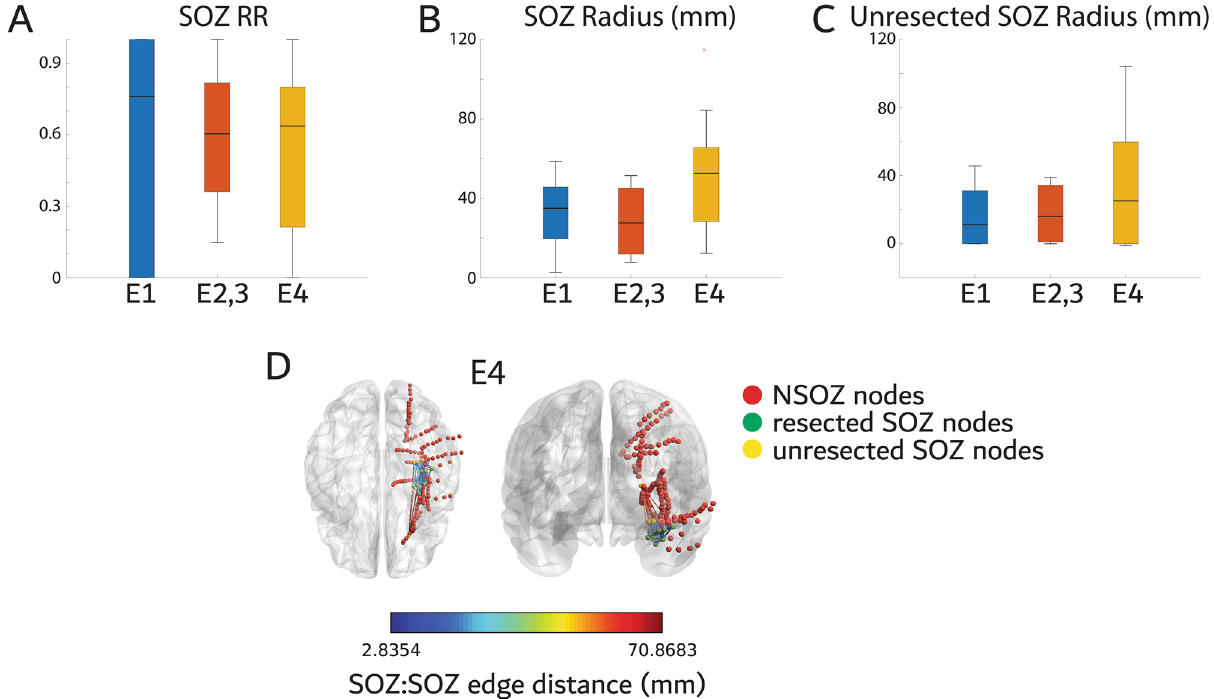
Figure 1. The proportion of the seizure onset zone (SOZ) resected, and the radius of the spatial network of all and unresected SOZ electrodes does not correlate with post-operative seizure outcome. ( A ) Box plot of the SOZ resection ratio (RR) stratified by Engel (E) outcome for all the patients in the cohort (Spearman, p > 0.05). ( B ) Box plot of the SOZ radius stratified by Engel outcome (Spearman, p > 0.05). ( C ) Box plot of the unresected SOZ radius stratified by Engel outcome (Spearman, p > 0.05). ( D ) Illustration of the SOZ distance network for a patient with an E4 outcome. Stereo EEG contacts in the non-SOZ are colored red, the contacts that were in the SOZ and resected are colored green and contacts that were both in the SOZ and unresected are colored yellow. The SOZ to SOZ (SOZ:SOZ) contact edges are color coded by the Euclidian distance (see color bar). The radius is calculated from the network formed by these